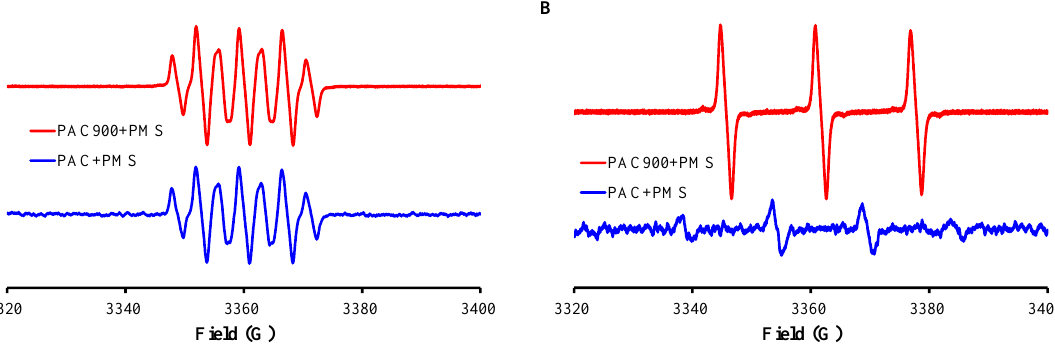
Figure 6. The pseudo second-order rate constants of OTC removal ( k 2 ) at different dose of ( A ) PAC or PAC900 (PMS 1 mM) and ( B ) PMS (PAC or PAC900 0.1 g/L) (OTC 25 mg/L, initial pH 6.0, 20 ± 2 °C).